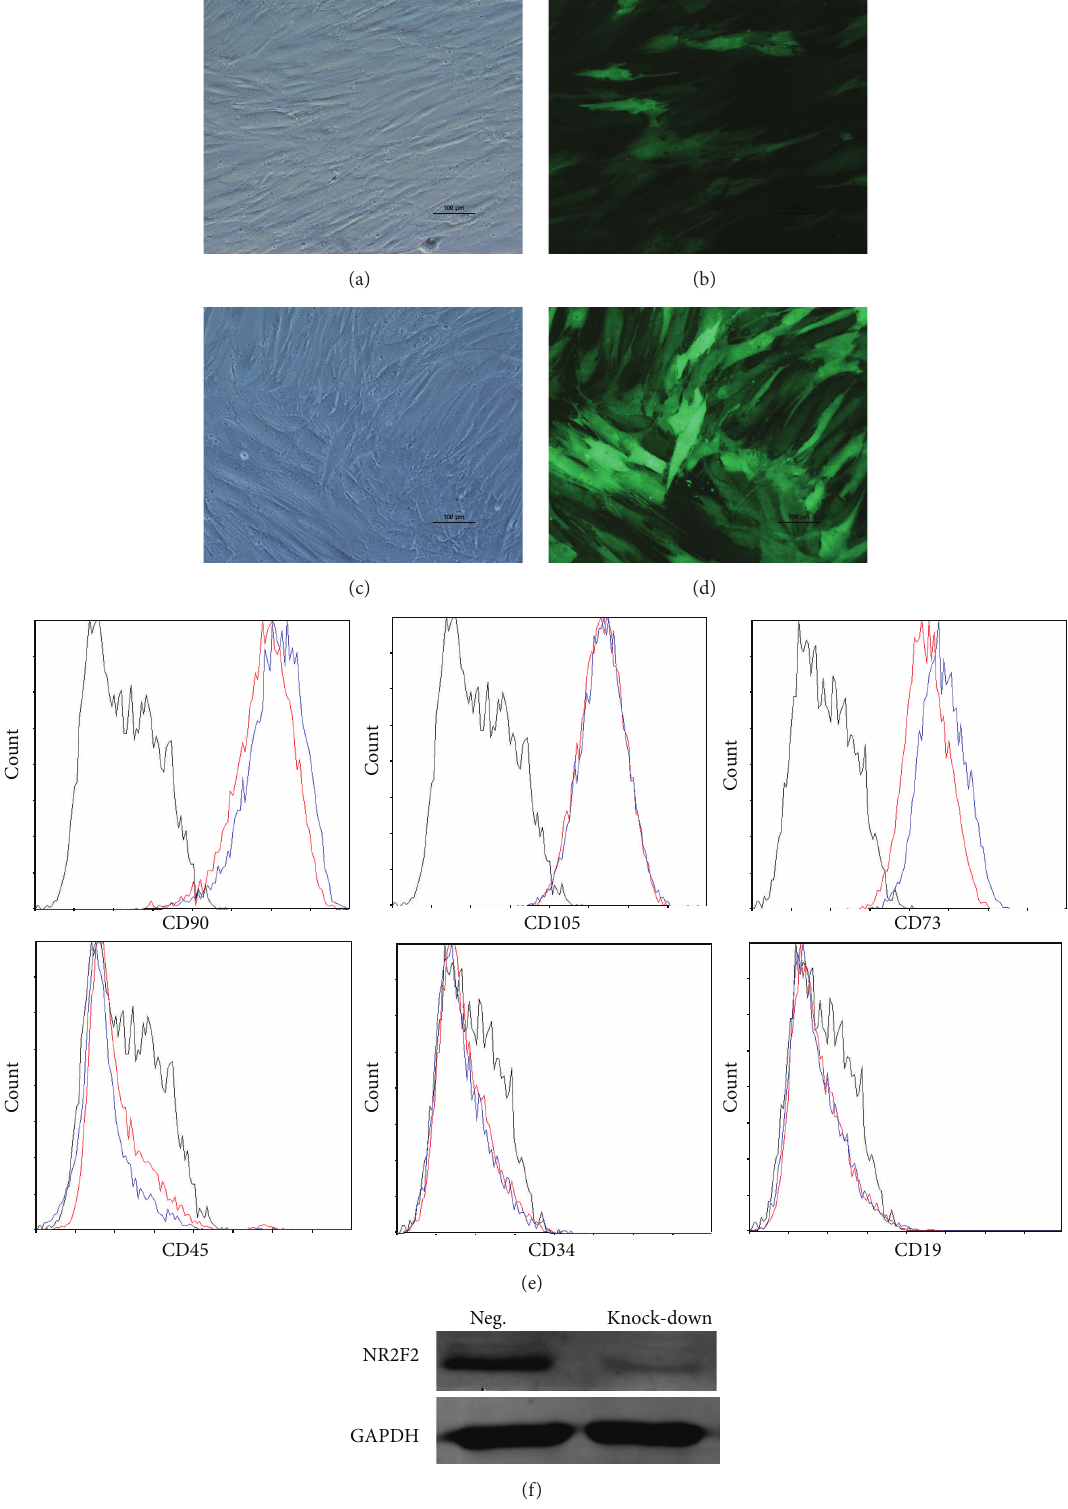
Figure 2: Characteristics of transfected BM-MSCs. (a) Representative morphology of transfected BM-MSCs in negative control group. (b) More than 90% of BM-MSCs expressed GFP in negative control group. (c) Representative morphology of transfected BM-MSCs in knock- down group. (d) More than 90% of BM-MSCs expressed GFP in knock-down group. (e) Representative flow cytometric characterization of cell surface markers expressed on transfected BM-MSCs. Isotypic controls were represented by black line. The red line represented the negative control group and the blue line represented the knock-down group. (f) The knock-down of NR2F2 was confirmed by western blot